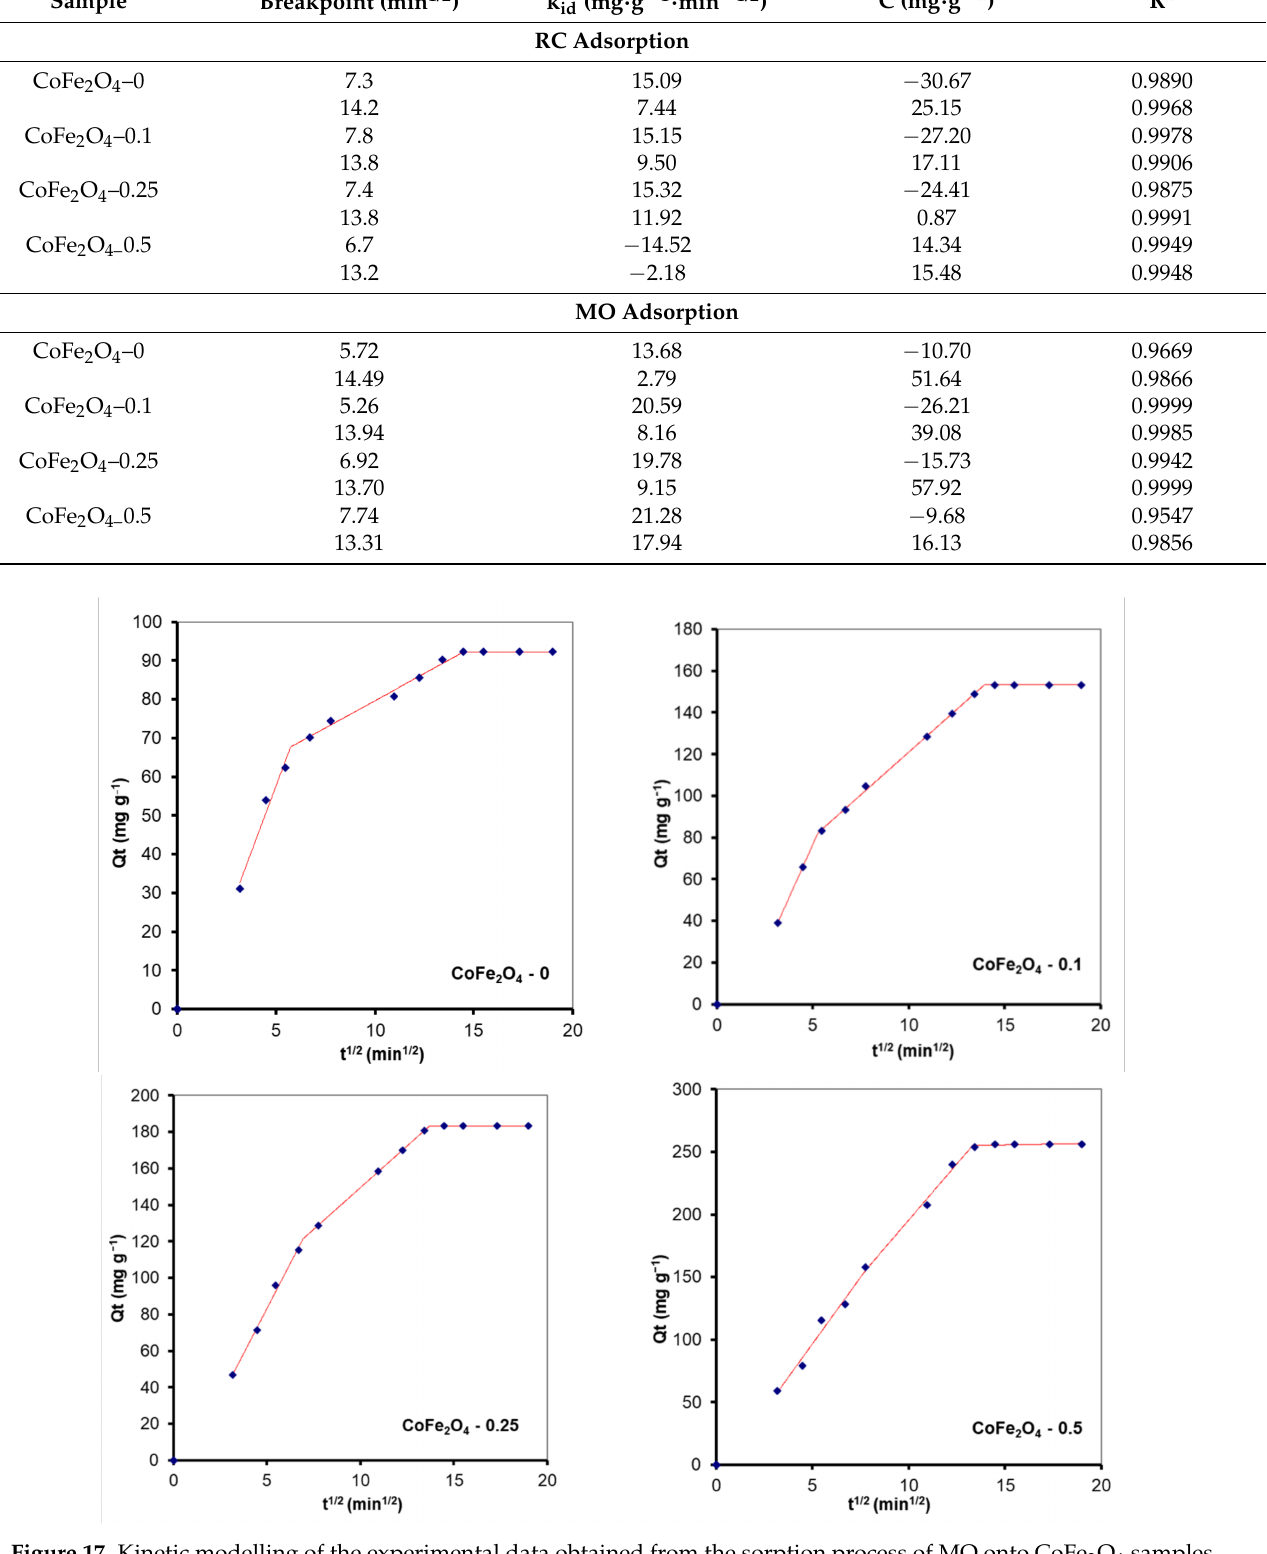
Figure 17. Kinetic modelling of the experimental data obtained from the sorption process of MO onto CoFe 2 O 4 samples using the intraparticle diffusion